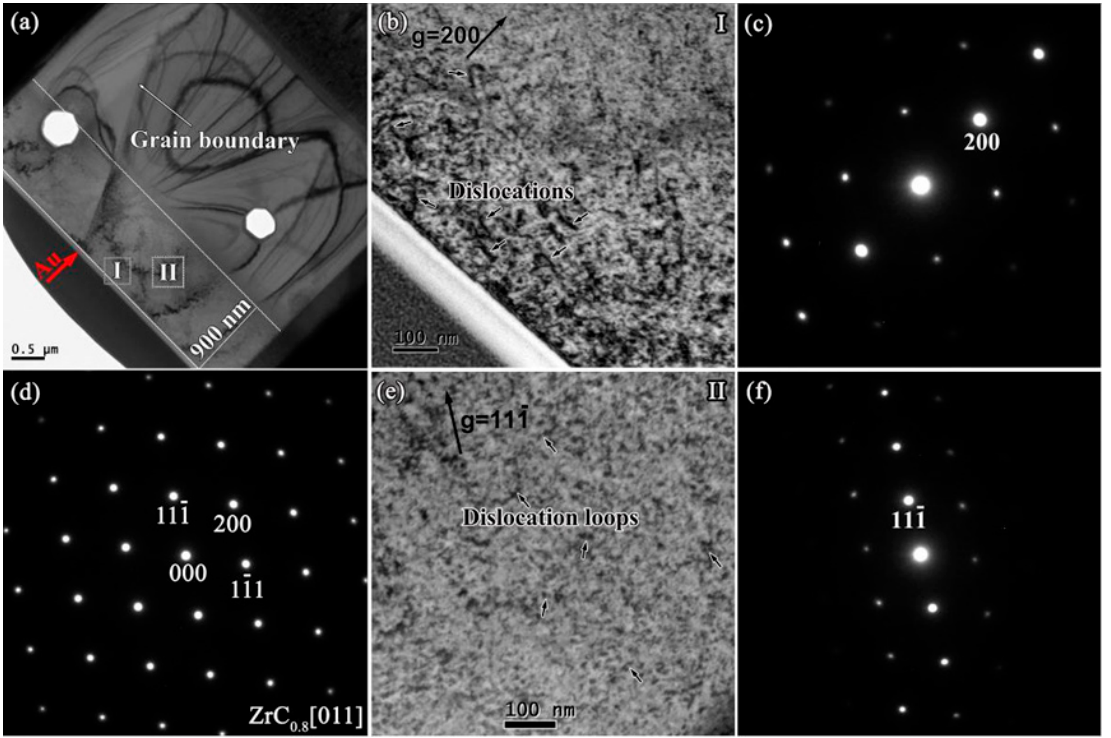
Figure 8. ( a ) Cross-section BF-TEM images of ZrC 0.8 after irradiation; ( b ) BF image of irradiated ZrC0.8 at Region I taken from ( c ) a two-beam condition diffraction pattern with g = 200 near the zone axis [011]; ( d ) SAED patterns obtained from the zone axis [011] of the damaged area; ( e ) BF image of irradiated ZrC 0.8 at region II taken from ( f ) a two-beam condition diffraction pattern with g = 111 near the zone axis [011].